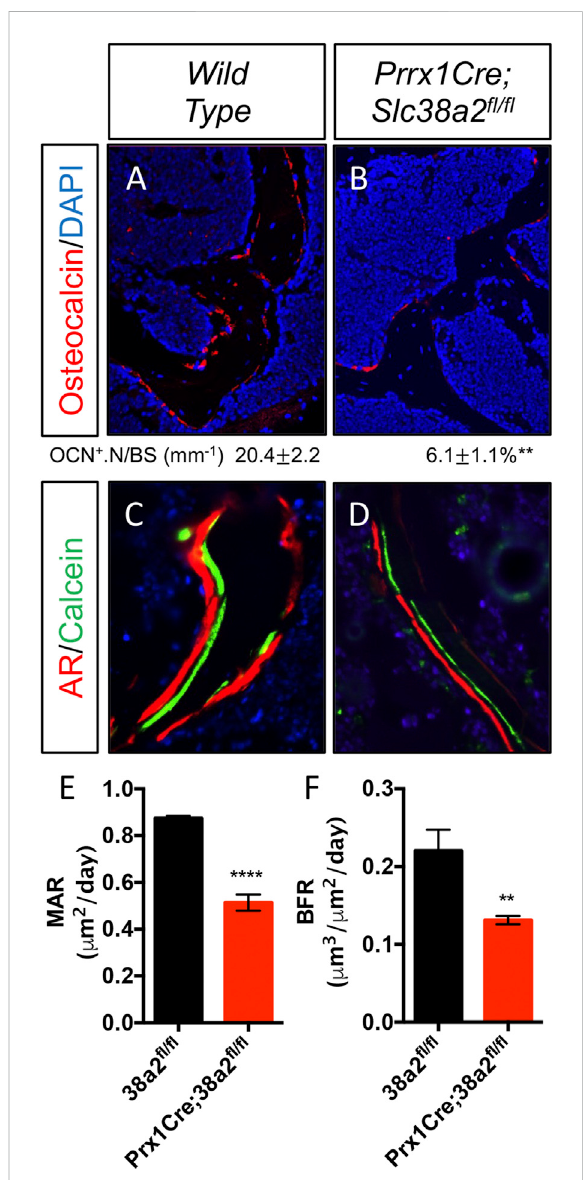
FIGURE 3 Decreased osteoblast numbers and activity in Prrx1Cre; Slc38a2 fl / fl mice. (A – B) Representative Osteocalcin (OCN) immuno fl uorescent staining of 4-month-old femur trabecular bone. (C – D) Representative calcein and alizarin red double labeled sectionsofthe distal femur from 4-month-old mice. (E – F) Quanti fi cation of mineral apposition rate (MAR) or bone formation rate (BFR) derived from double labeling. ** p < 0.005, **** p < 0.00005, N ≥ 3.